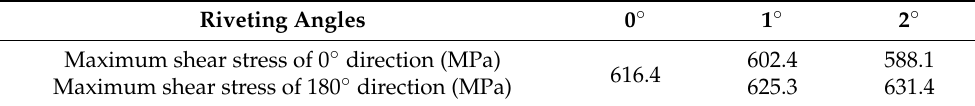
Table 7. Maximum shear stress of rivet at different riveting angles and